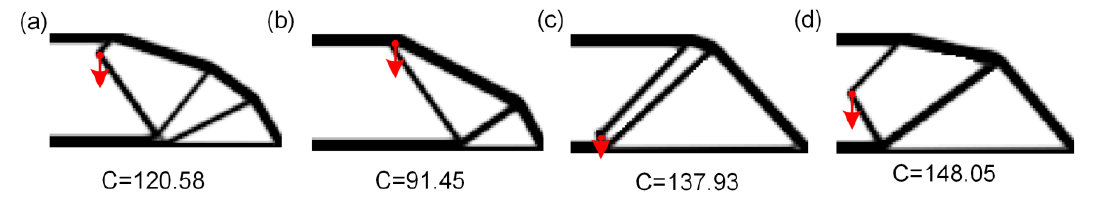
Figure 2. Part of structural optimization results (the red arrow indicates load, and the value of C indicates compliance) with different values of C. ( a ) C = 120.58, ( b ) C = 91.45, ( c ) C = 137.93, ( d ) C = 148.05.